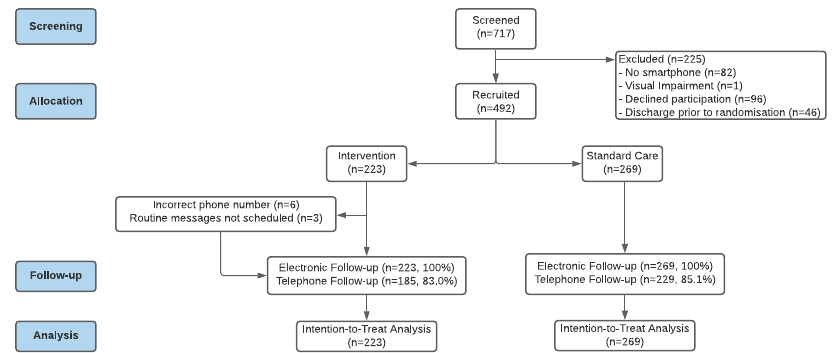
Fig. 1 CONSORT fl ow diagram. The patient fl ow for the TWIST trial.